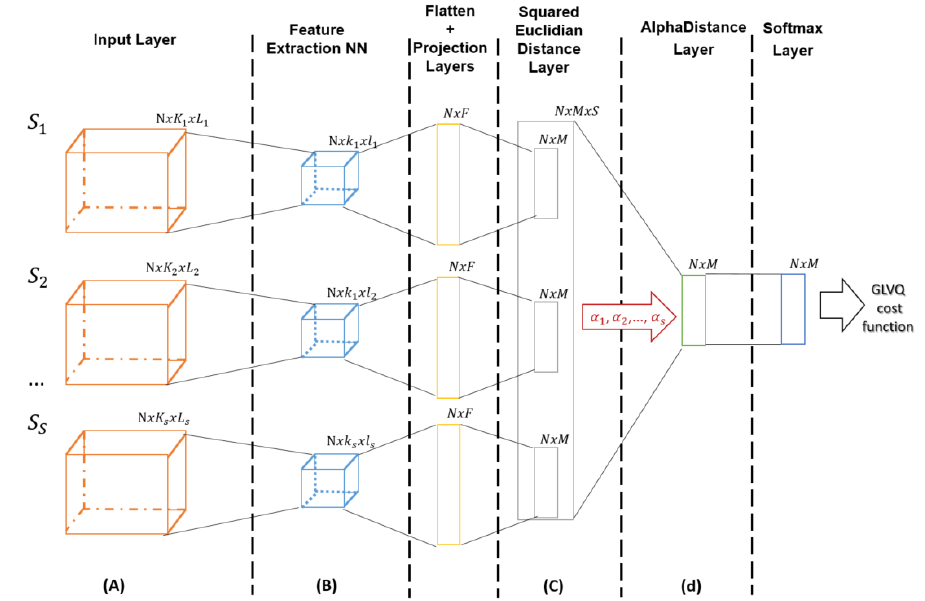
Figure 2. Multi-input bi-functional system layers with corresponding dimensions